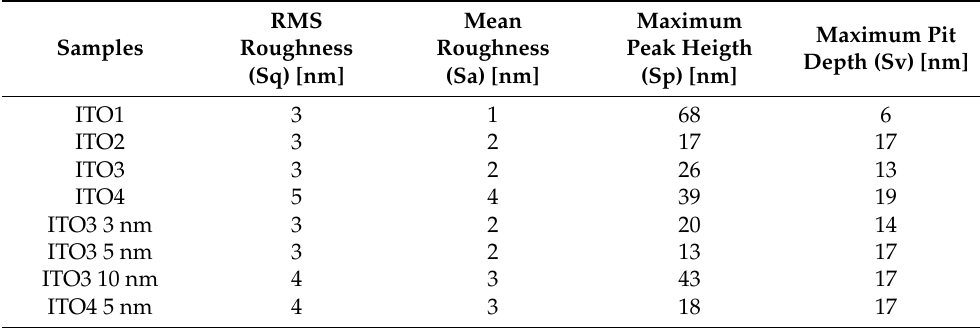
Table 3. AFM roughness analysis of ITO1, ITO2, ITO3, ITO4 surface and ITO3/3 nm, ITO3/5 nm, ITO3/10 nm, ITO4/5 nm Ag NPs.